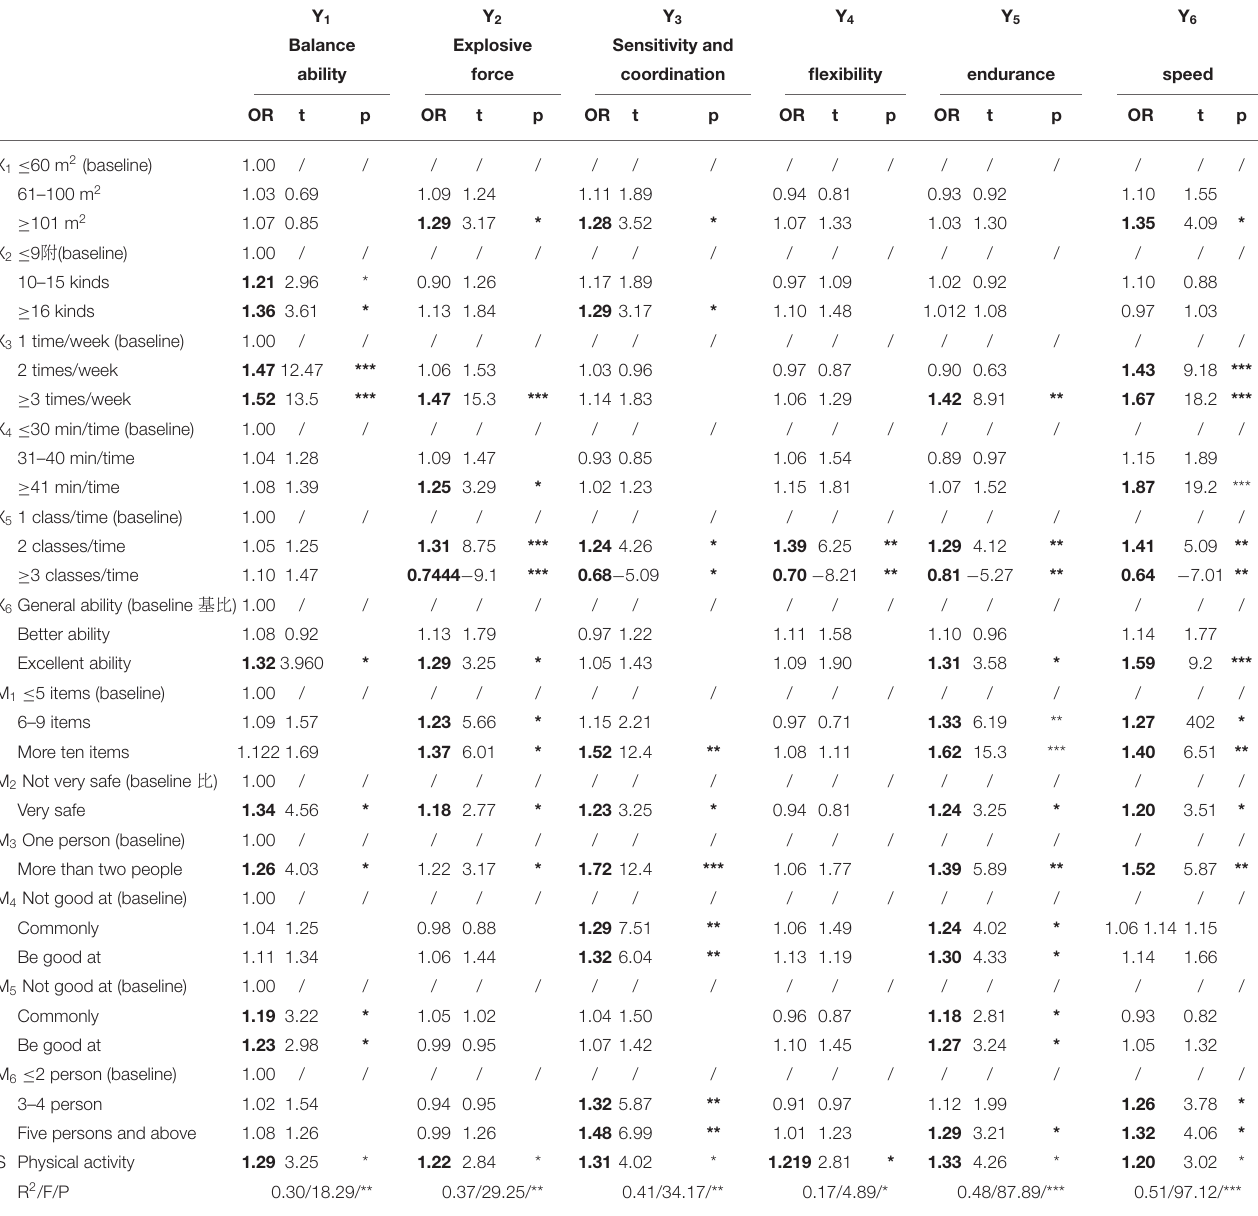
TABLE 3 | Statistical table of logistic regression analysis of the impact of family and kindergarten environment and children’s physical activity on their Healthy physical fitness. Y 1 Balance Explosive Sensitivity and ability force coordination flexibility endurance speed OR t